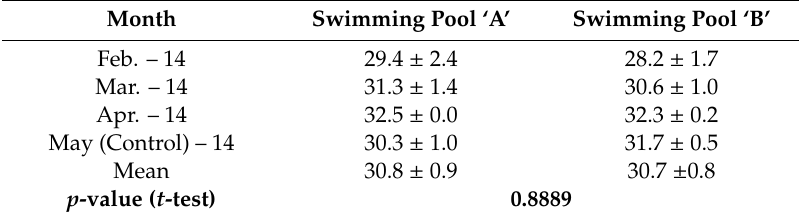
Table 1. Mean and p -values of swimming pool water temperatures in the Tamale